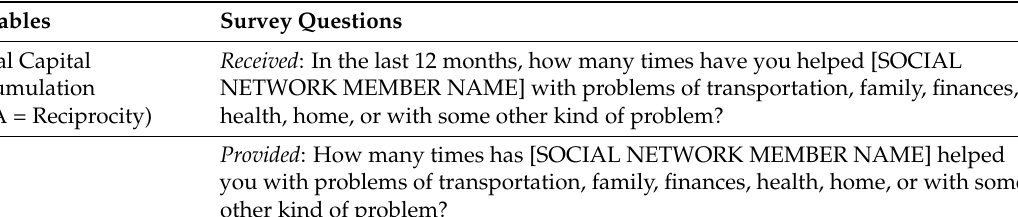
Table 1. Survey Questions Used for Variable